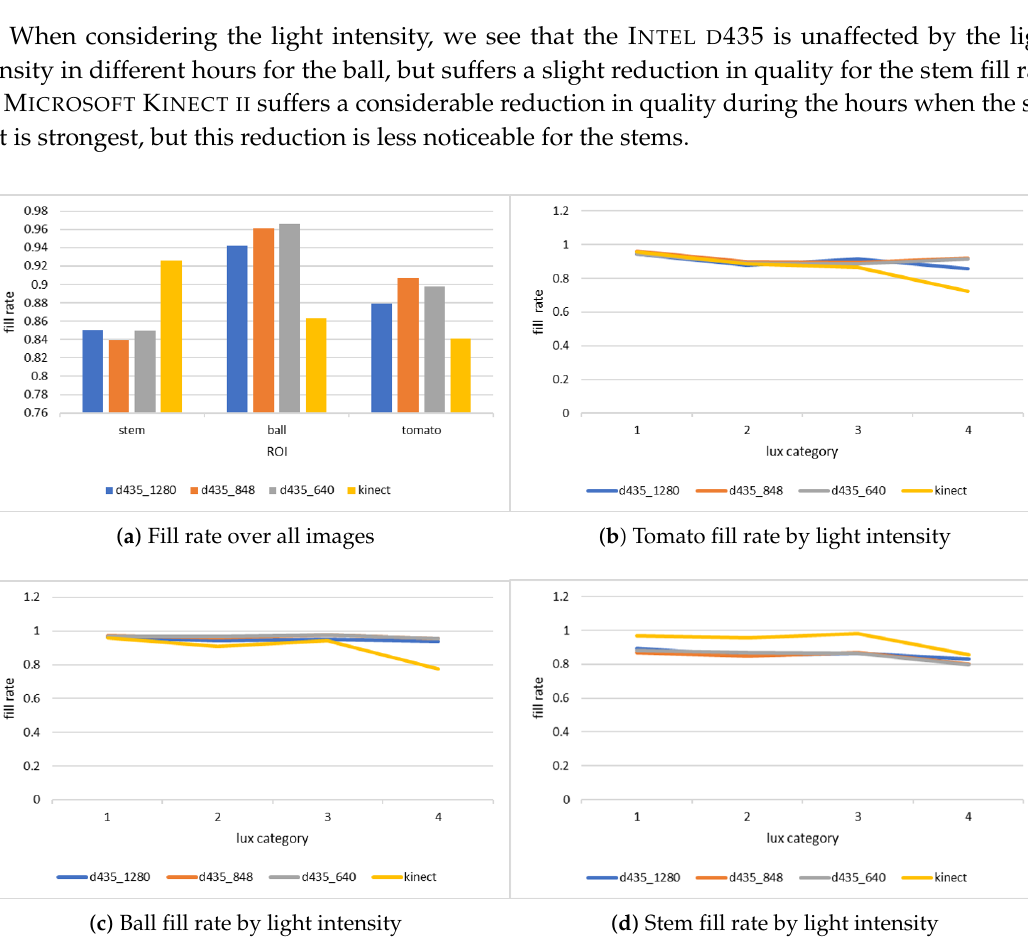
Table 3. mAP results for the object detection task using only RGB data. Sensor